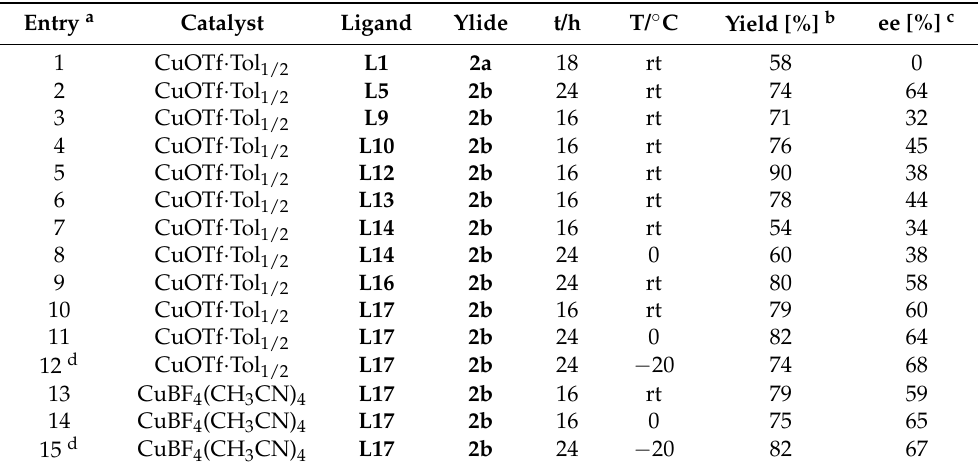
Table 1. Optimization for Catalytic Asymmetric [3 + 1]-Cycloaddition Reaction of 1a with 2a / 2b a